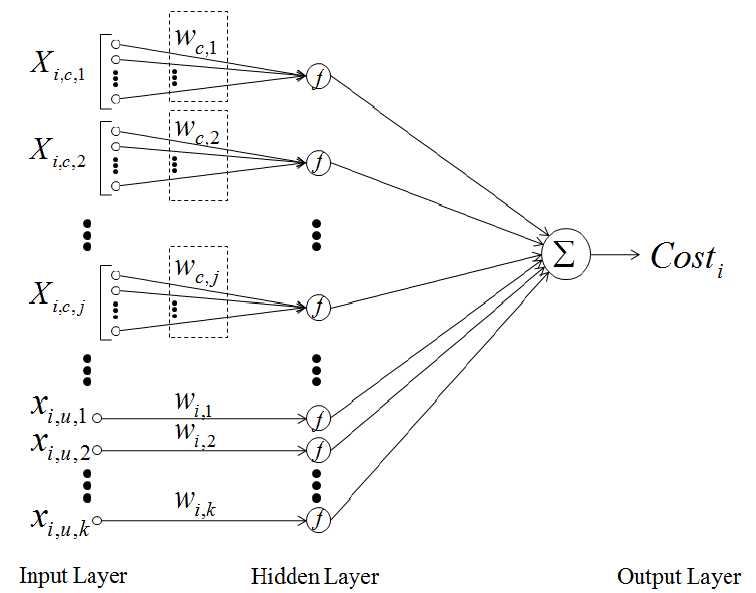
Figure 3. Link cost function represented in